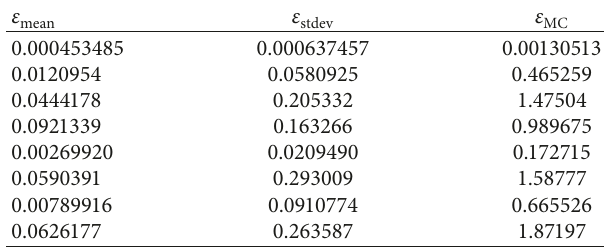
Table 3: The errors between eigenvalues computed by collocation ) and Monte Carlo ( ω 2 ) methods. The eight smallest (in ( ω 2 C MC expected value) eigenvalues of the tower